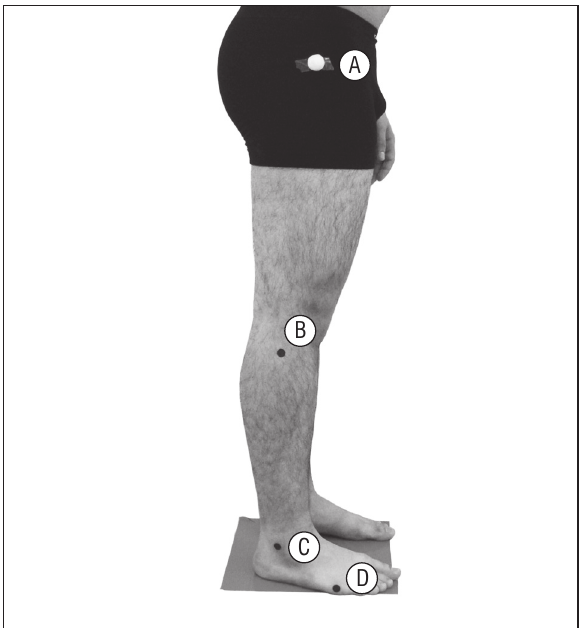
Figura 1 - Posicionamento para a coleta das imagens Legenda: A = indivíduo posicionado para a coleta das imagens; B = câmera fotográ fi ca; C = posição dos pés; D = distância entre a câmera e o voluntário; E = distância entre a câ-